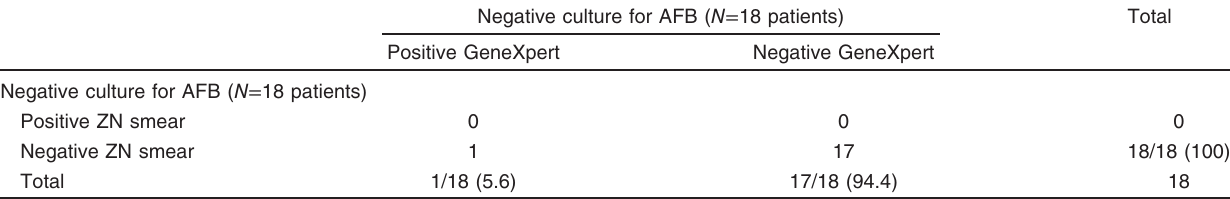
Table 3 GeneXpert test and Ziehl – Neelsen examination results among patients with negative culture for tuberculosis